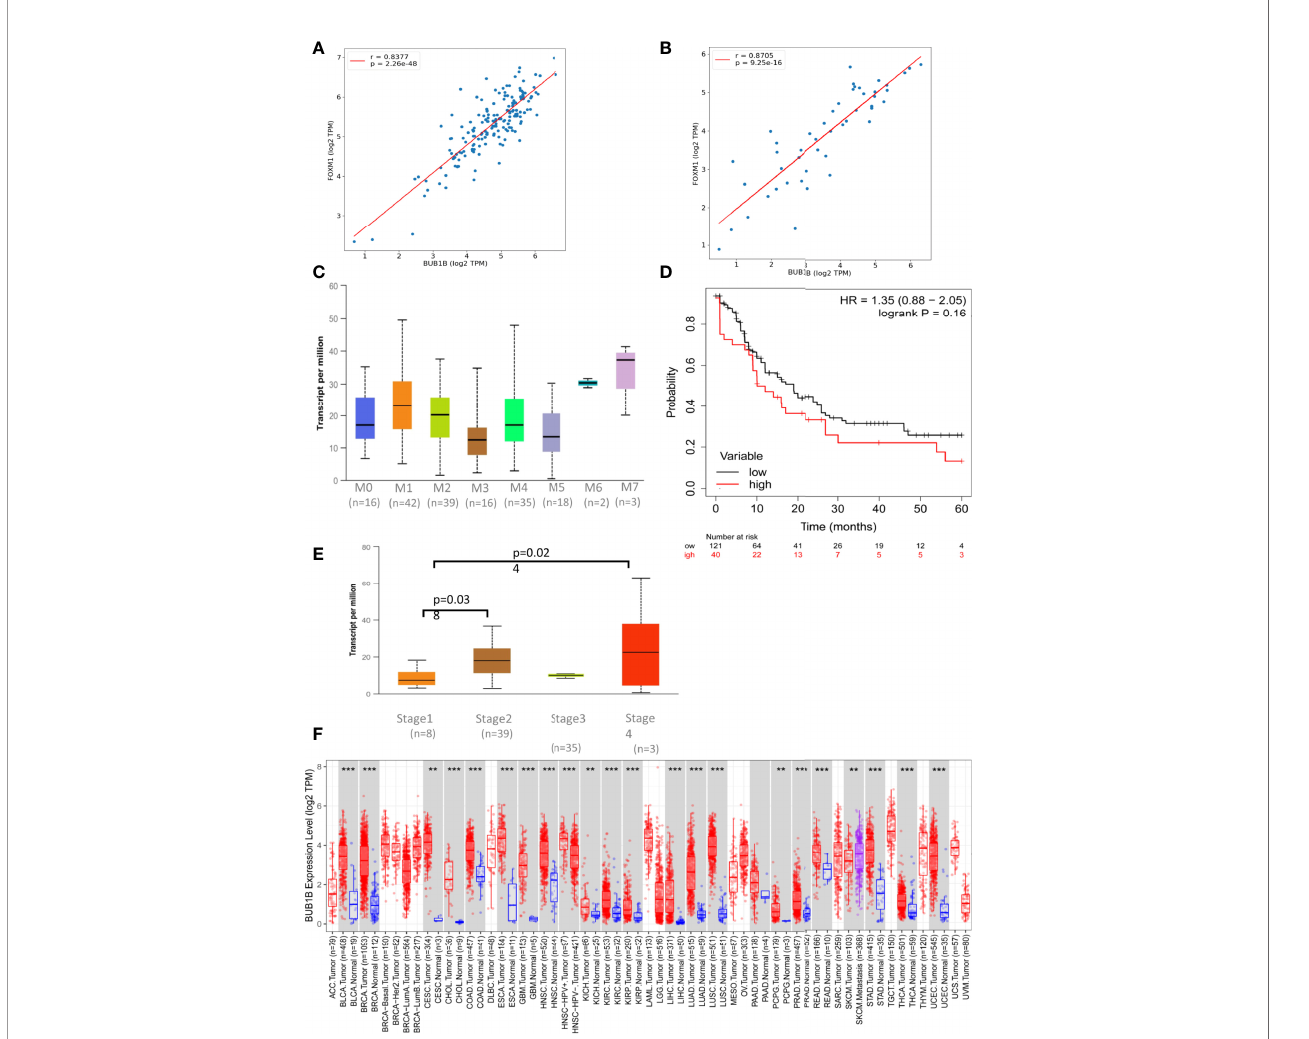
FIGURE 4 | BUB1B expression and association in TCGA: (A) Spearman correlation between BUB1B and FOXM1 in AML plotted using log2 Transcript Count Per Million (TPM) expression values. (B) Spearman correlation between BUB1B and FOXM1 in DLBC plotted using log2 TPM expression values. (C) Expression of BUB1B in different subtypes of Acute Myeloid Leukemia (AML). The expression values are normalized in TPM. (D) Kaplan Meier Curve showing overall survival between BUB1B high and low expression patients in AML. (E) Expression of BUB1B in different stages of DLBC. The expression values are normalized and plotted as Log2 TPM. (F) Log2 TPM expression of BUB1B in TCGA hematological and solid malignancies. Signi fi cant differential expression between tumor and normal tissues or between tumor subtypes is calculated using Wilcoxon test and the signi fi cance level is annotated by the number of stars on top of box plots (**p < 0.01; ***p < 0.001). This fi gure was generated using TIMER2.0 (http://timer.cistrome.org/) TCGA abbreviations are expanded in Supplementary Figure 1